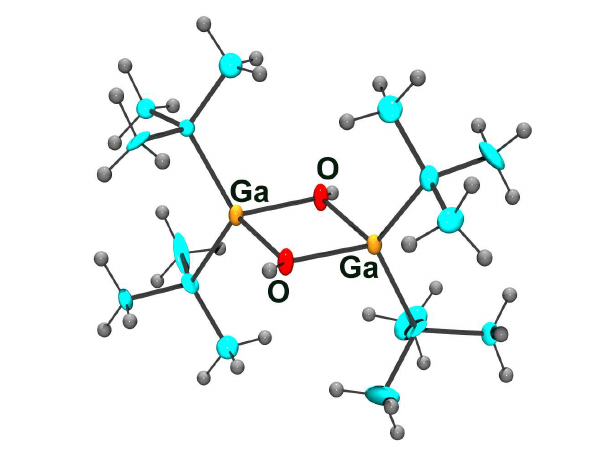
Figure 2 . Molecular structure of [( t -Bu) Ga( m -OH)] . The associated macrocycle units are not shown. 2 2 The entities in the unit cell are related by non-crystallographic pseudo symmetry. Each gallium dimer possesses almost an inversion center and the two independent units with their associated macrocycles are related by pseudo translational symmetry of (x, ½+y, ½ +z). It is tempting to assume that the structure could be described by this higher symmetry. However these relations do not reflect an exact non-crystallographic symmetry as the deviations are more than an order of magnitude larger than the standard deviation of the atomic positions, and this explains the failure to refine the structure in P-1. The choice of the acentric space group P1 is supported by the observation that refinement in P1 did not show any correlations between the atoms related by pseudo